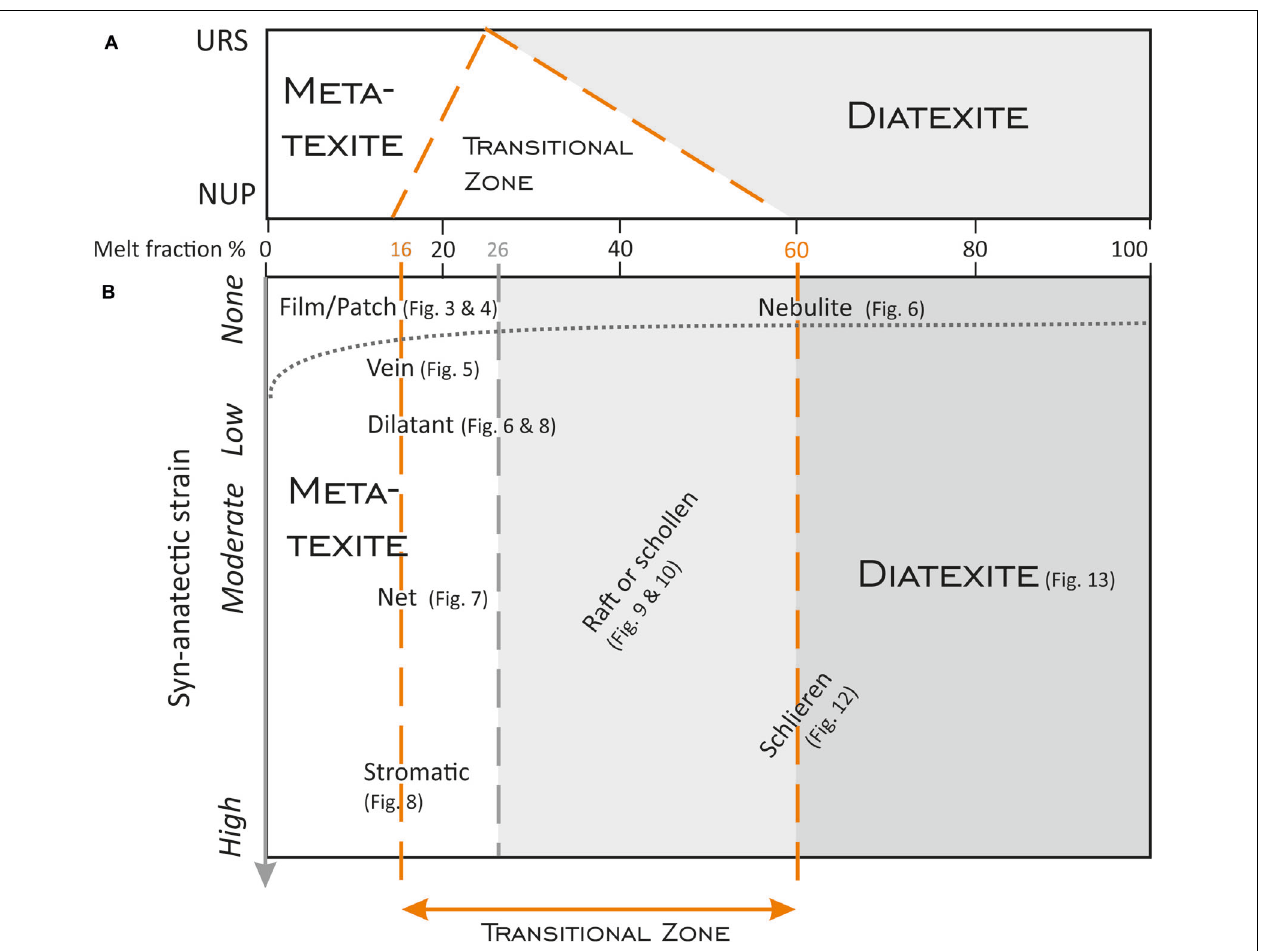
FIGURE 2 | Morphological division of migmatites. (A) Twofold division of migmatites into metatexites and diatexites based on melt fraction percentage and properties of solid grains (URS, uniform rigid spheres, NUP, non-uniform particles) in a partially melted rock. (B) Further division of the migmatite morphology by melt fraction and syn-anatectic strain. The gray dashed vertical line indicates an abrupt transition at 26% melt fraction (URS model) and orange dashed vertical lines indicate the transitional zone between 16 and 60% melt fraction (NUP model). Modified from Sawyer